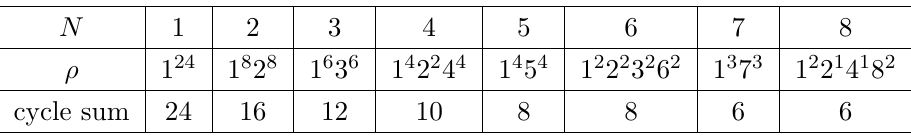
Table 2 . Cycle shapes for Z N orbifolds of K3 (cid:2) S 1 (cid:2) e S 1 .